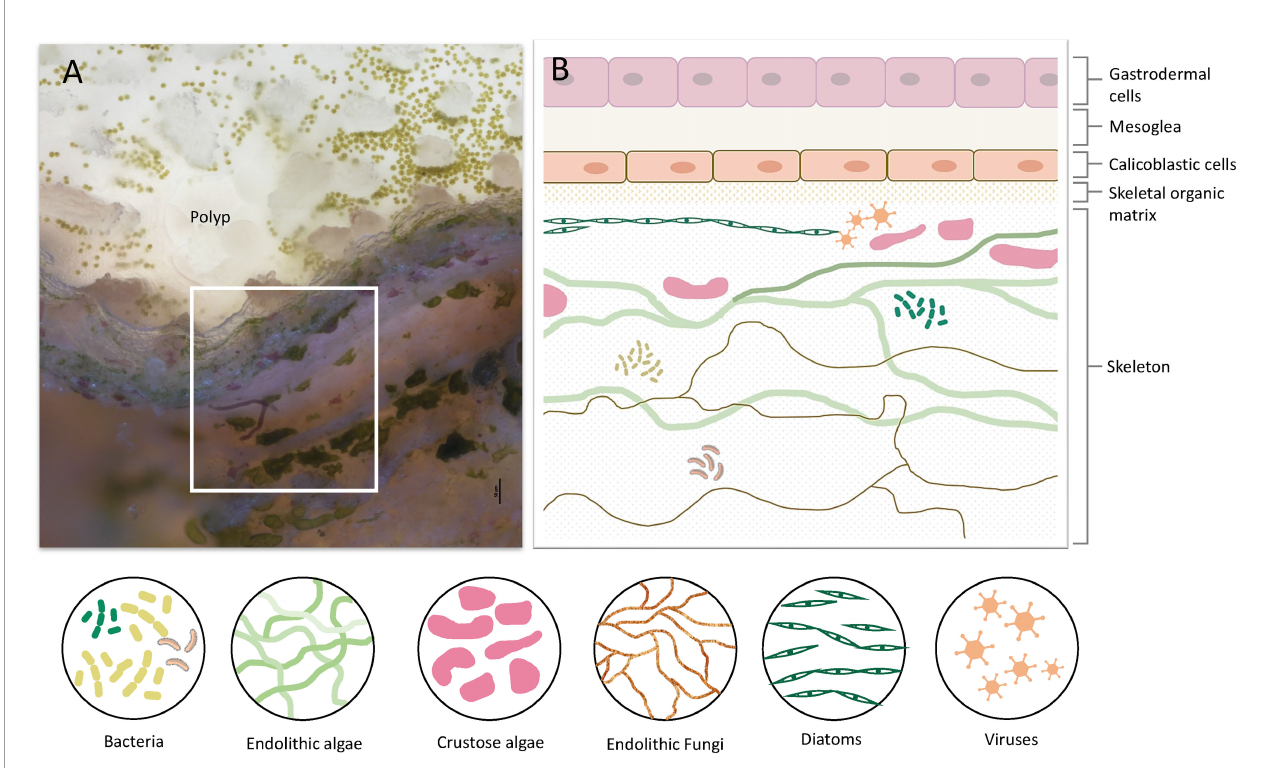
FIGURE 1 | Coral tissue and skeleton layers and the diversity of organisms residing within the skeleton. (A) A cross-section of live S. pistillata coral. The polyp and coral tissue are on top (transparent white). Green dots in the tissue are the symbiotic algae ( Symbiodinium ). On the bottom half, there are skeleton layers with a diversity of microorganisms. (B) Illustration of the coral cell layers, and coral skeleton layers denoted in the white box in A, including the eukaryotic and prokaryotic microorganisms within the skeleton. The cell layer aligned with the skeletal organic matrix is the calicoblastic cell layer, which is involved in skeleton formation and in extracting molecules and proteins into the skeletal organic